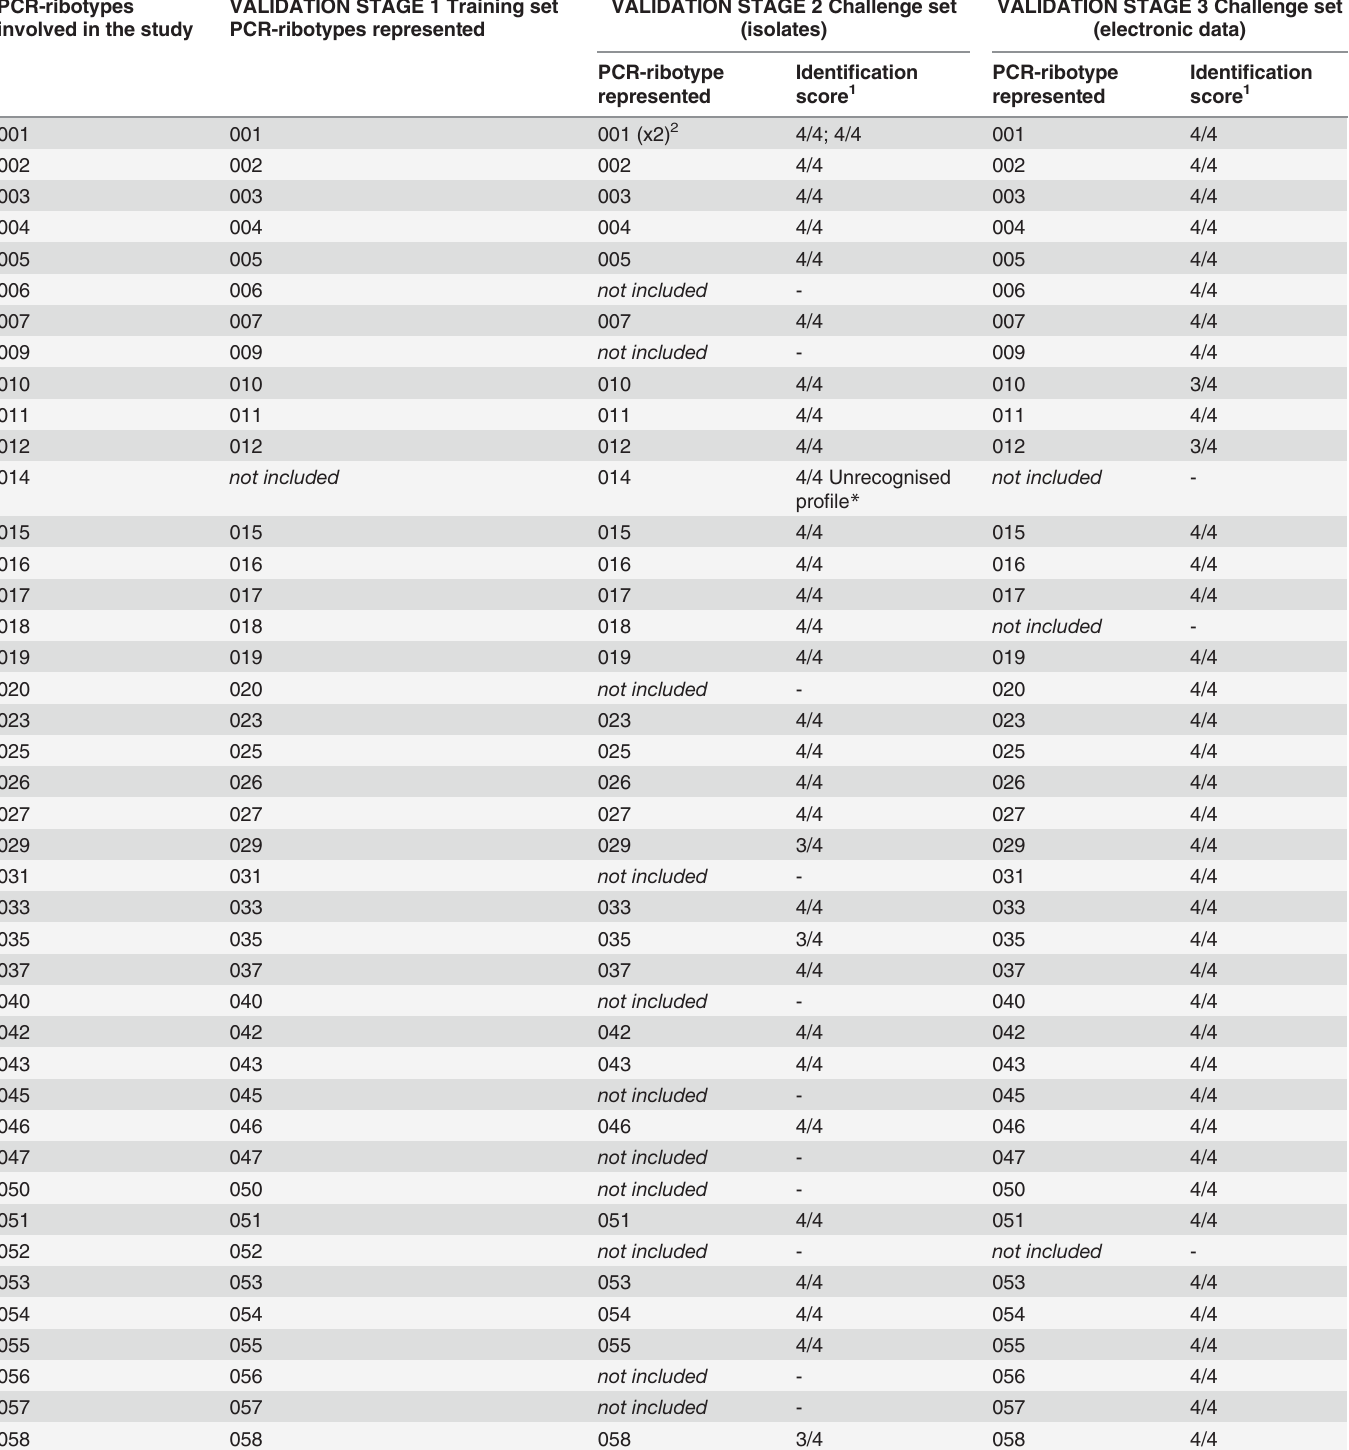
Table 1. PCR-ribotypes represented in the study and identi fi cation performance of the testing laboratories at subsequent validation stages of the CE-ribotyping protocol. PCR-ribotypes involved in the